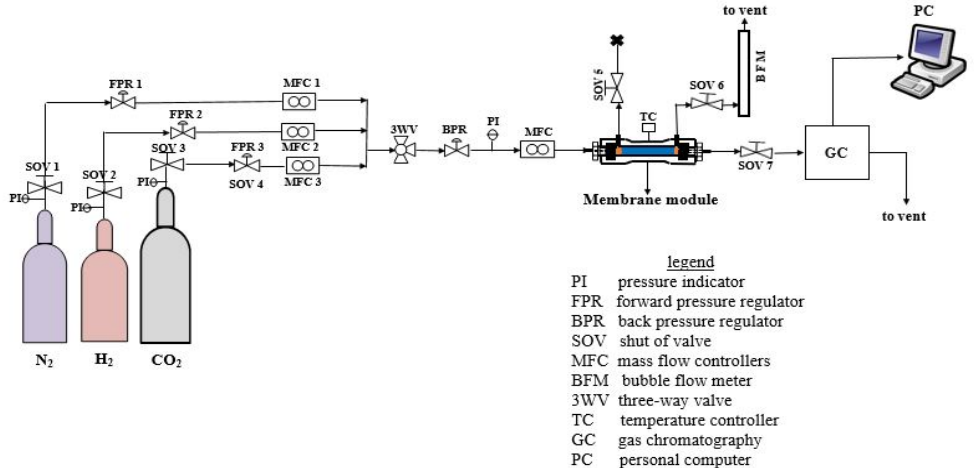
Figure 3. Process Flow Diagram (PFD) of the permeation set-up employed for single and mixture gas permeation experiment.